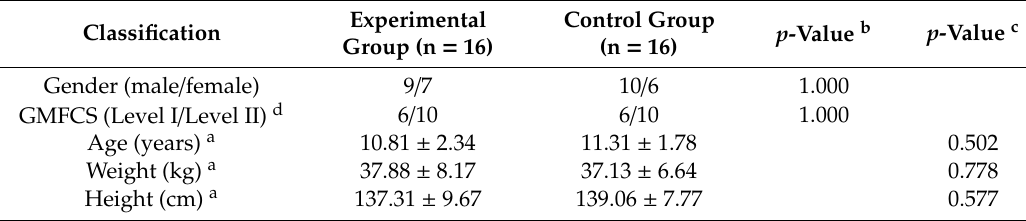
Table 1. General characteristics of the recruited subjects.